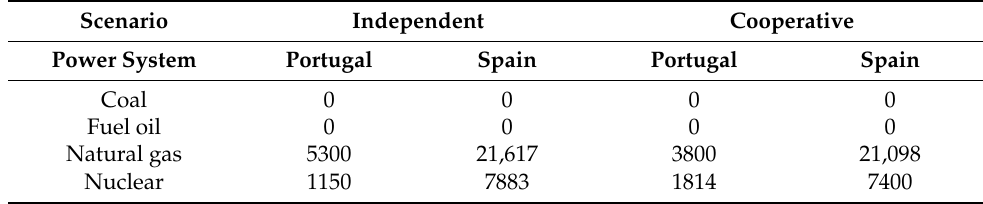
Table 7. Optimal thermal capacity (MW) in